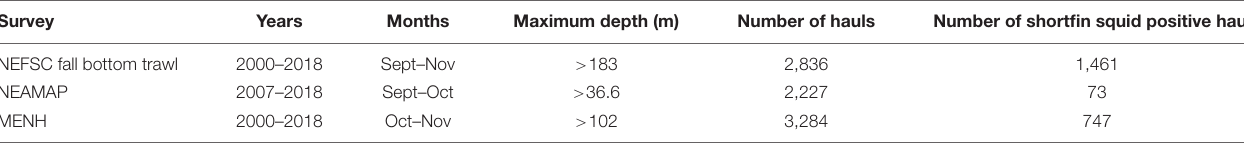
TABLE 1 | Fishery-independent surveys used for building shortfin squid habitat map.